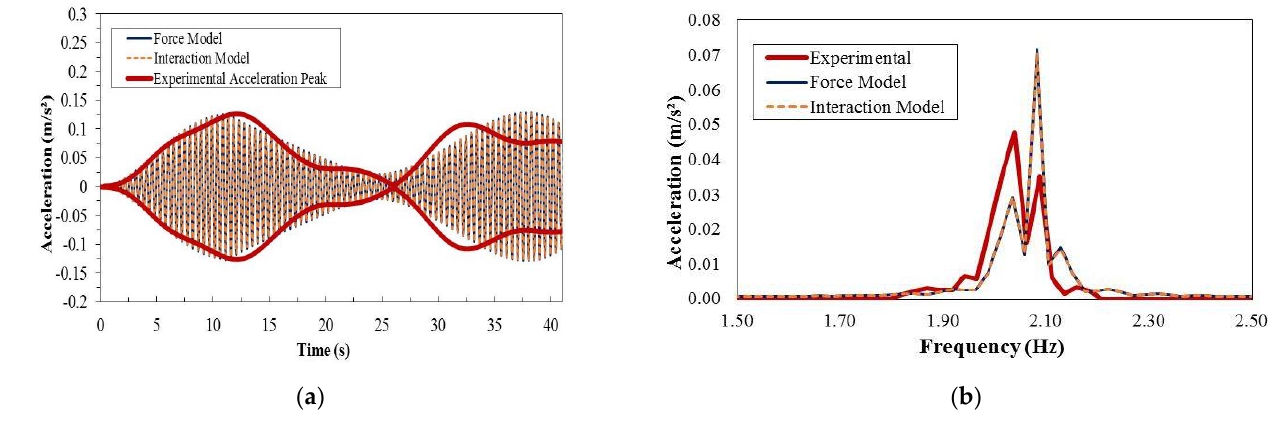
Figure 8. Third crossing of Test Subject 2: ( a ) time response; ( b ) spectrum. Table 3. Calculated dynamic load factors (DLFs) of the test subjects.